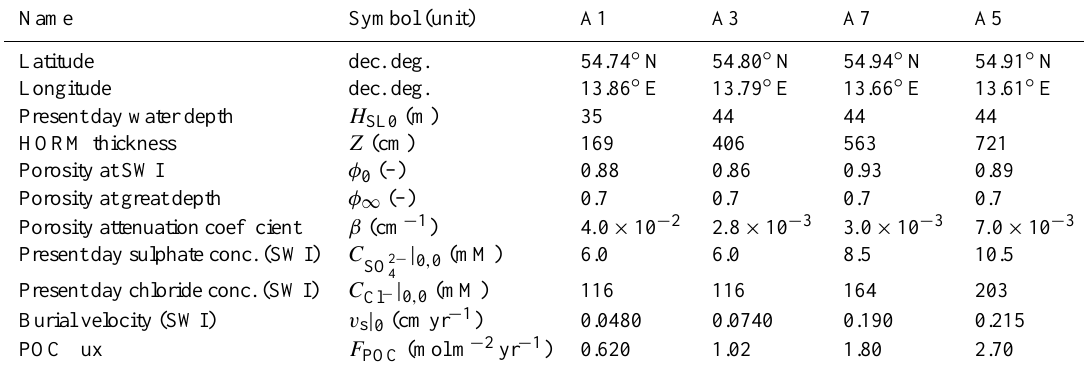
Table 3. Site specific data corresponding to the cores modeled in this